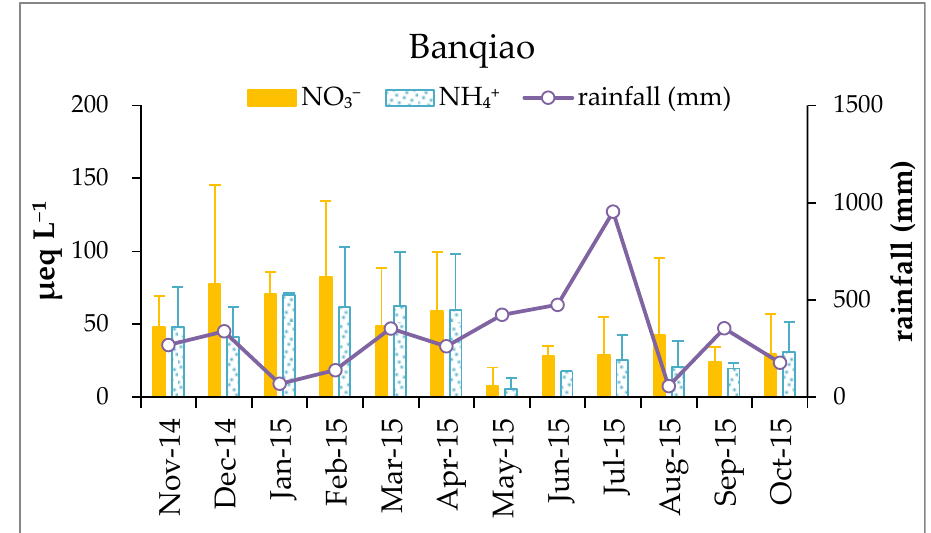
Figure 6. Variations in the monthly average concentrations of NO 3− and NH 4+ at Wanli and Banqiao. (error bars represent the standard deviations for each month).